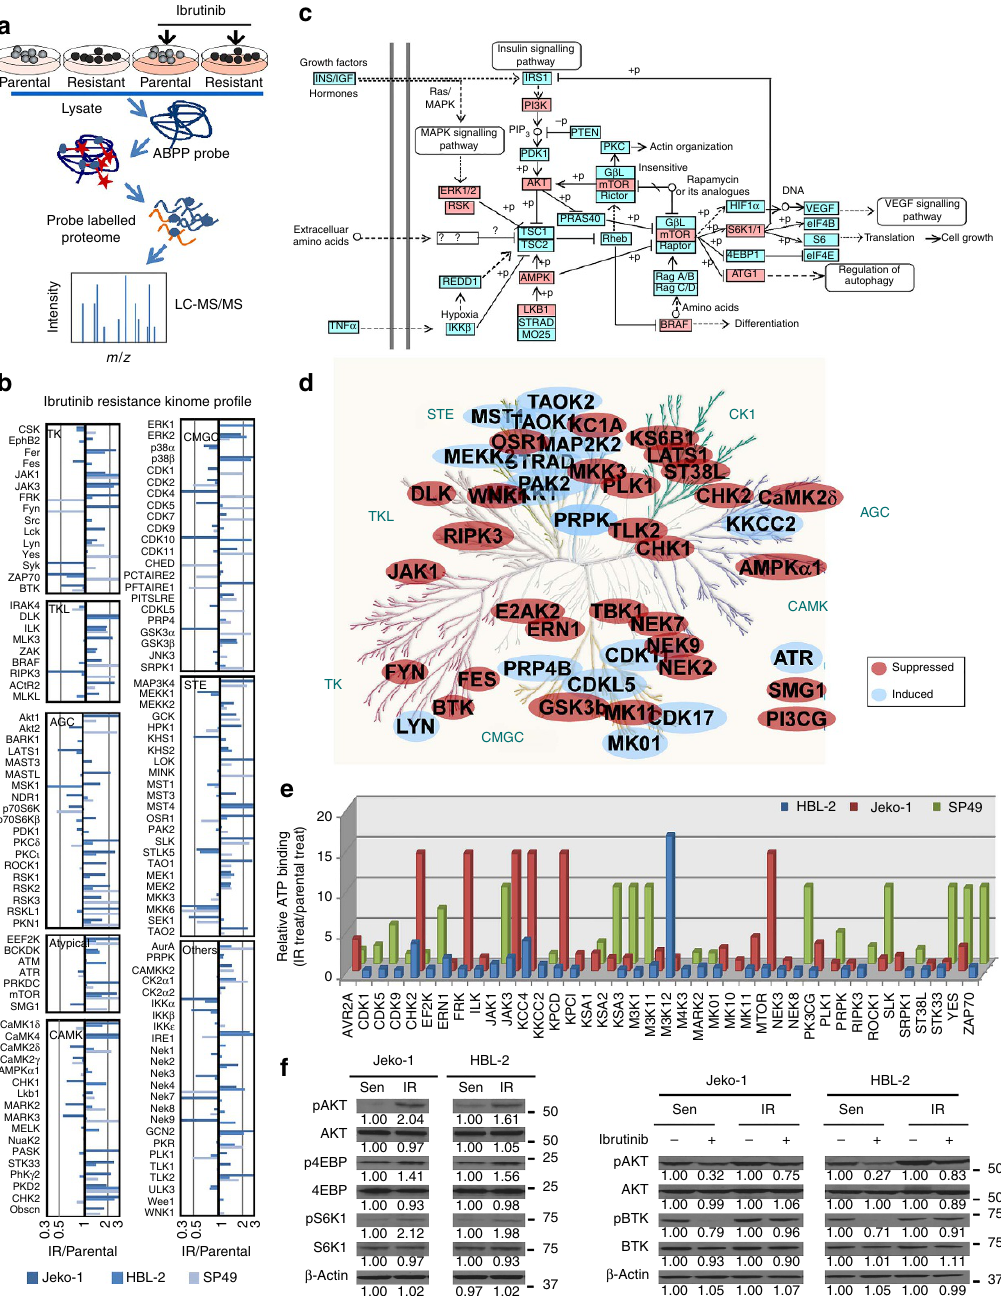
Figure 2 | Chronic ibrutinib treatment leads to kinome reprogramming and PI3K-AKT-mTOR pathway activation and ibrutinib resistance in MCL cells. ( a ) Schematic workflow of activity-based protein profiling (ABPP) to identify global kinome changes in MCL cells. Briefly, cell lysis were sonicated, desalted and followed by incubation with 10 m M desthiobiotin-ATP probes. The labelled proteins were reduced, alkylated and trypsin digested, and the labelled peptides were purified with high capacity streptavidin agarose resin, washed, eluted and subjected to LC-MS/MS for quantification. ( b ) Kinome profiling of IR MCL cells compared with parental cells (HBL-2, Jeko-1, SP49). Ratios Z 1 indicate increased kinase ATP probe binding with relative increased activity, and values o 1 indicate decreased ATP probe binding with decreased activity relative to parental cells. Data averages of two biological replicates. ( c ) KEGG pathway analysis map showing activation of PI3K-AKT-mTOR as a central signalling hub of kinome reprogramming for IR development. Pink, kinases with increased activity detected by ABPP. ( d ) Common kinase ATP-binding changes after 6-h ibrutinib treatment in all three parental MCL cell lines (Jeko-1, HBL-2, SP49). Kinome trees reproduced courtesy of Cell Signaling Technology. ( e ) Sustained kinase ATP-binding activity in IR MCL lines relative to their parental cell lines after 6h ibrutinib treatment. ( f ) Western blots showing increased AKT, 4EBP and S6K1 phosphorylation in Jeko-1-IR and HBL-2-IR cell lines, as well as sustained AKTactivation in the presence of ibrutinib (6 m M, 12h) treatment in IR cells compared with parental (Sen) cells. ( b , d , e ) are from two biological replicates with four technical replicates. Results in f are representatives of three independent experiments. The relative changes of proteins were measured by quantitative densitometry and indicated below each lane. See also Supplementary Figs 2, 8 for full gel scan of the